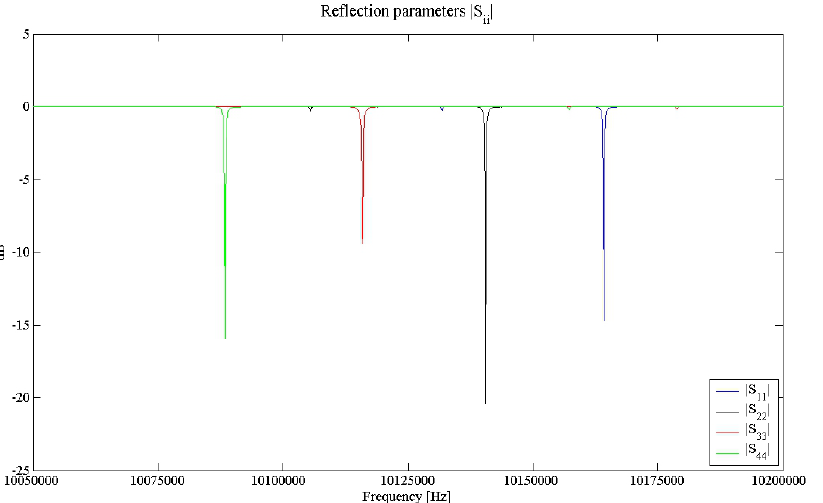
Figure 3. Moduli of the reflection parameters of the four ports network corresponding to the MQCM.